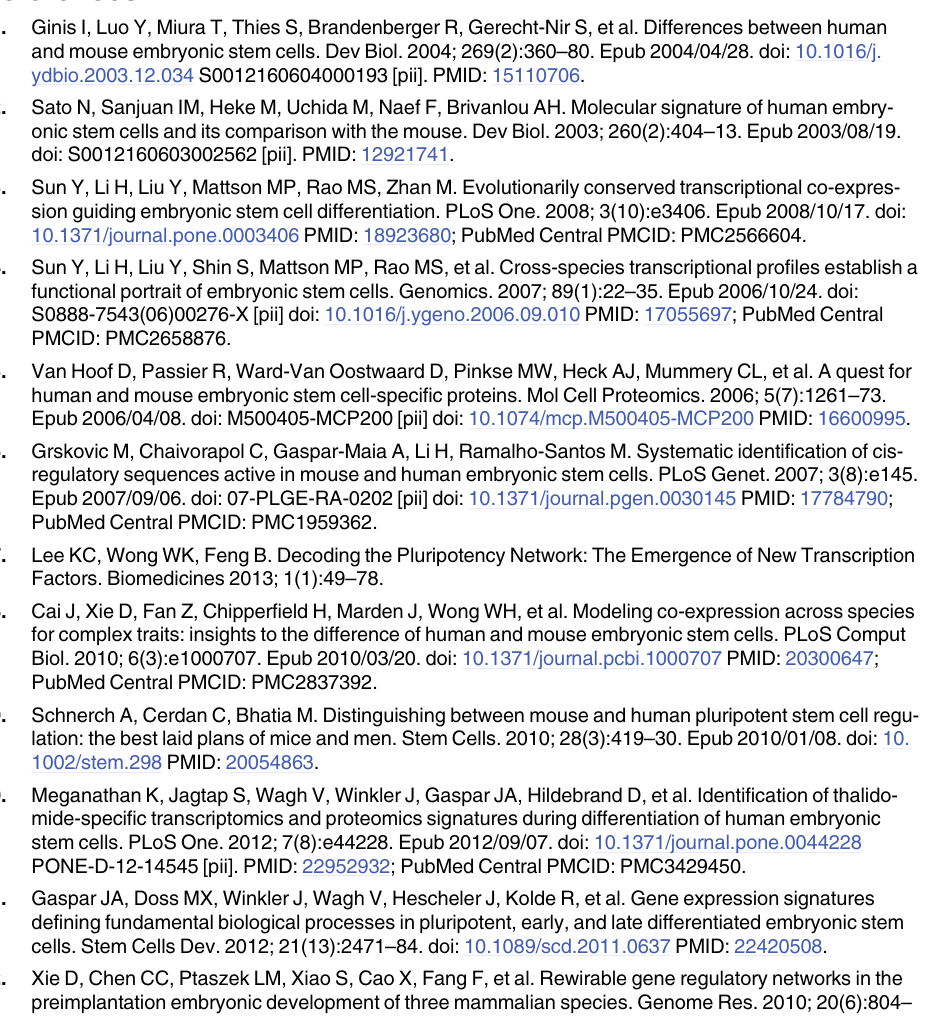
S8 Table. mESC clusters presented by probe sets. Probeset IDs for genes of the clusters from S7 Table. S9 Table. mESC clusters with gene description. Annotation of genes of the clusters from S7 Table. S10 Table. Lists of relevant TFs for hESC gene groups. TFs with binding sites found to be overrepresented with p-value < 10 − 9 on the promoters of